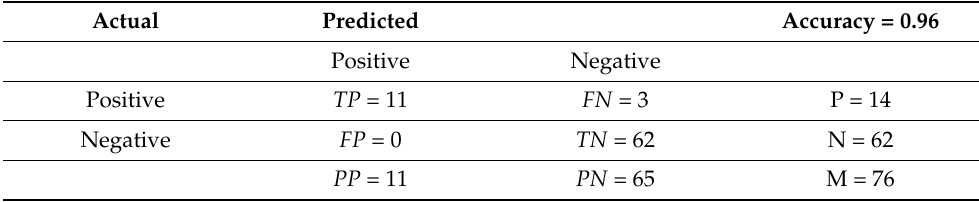
Table 3. Confusion Matrix for SVM test